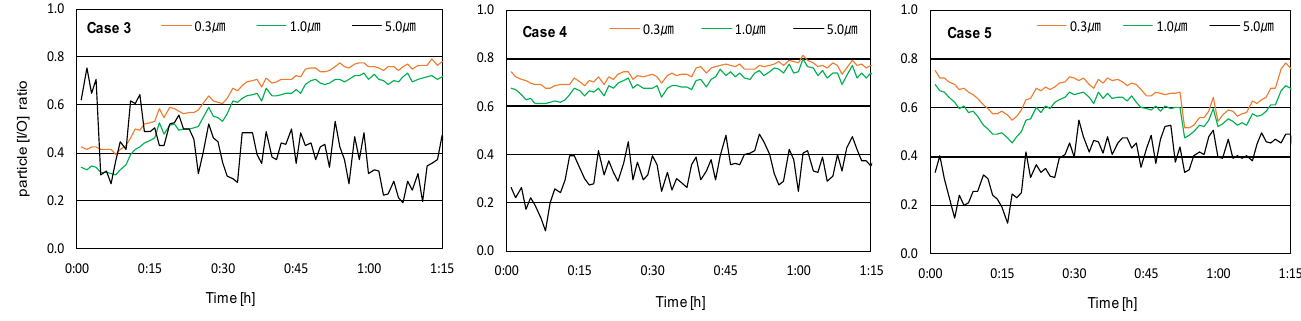
Figure 7. Particulate I/O ratio with a ventilation fan and natural ventilation (conditions 3–5).